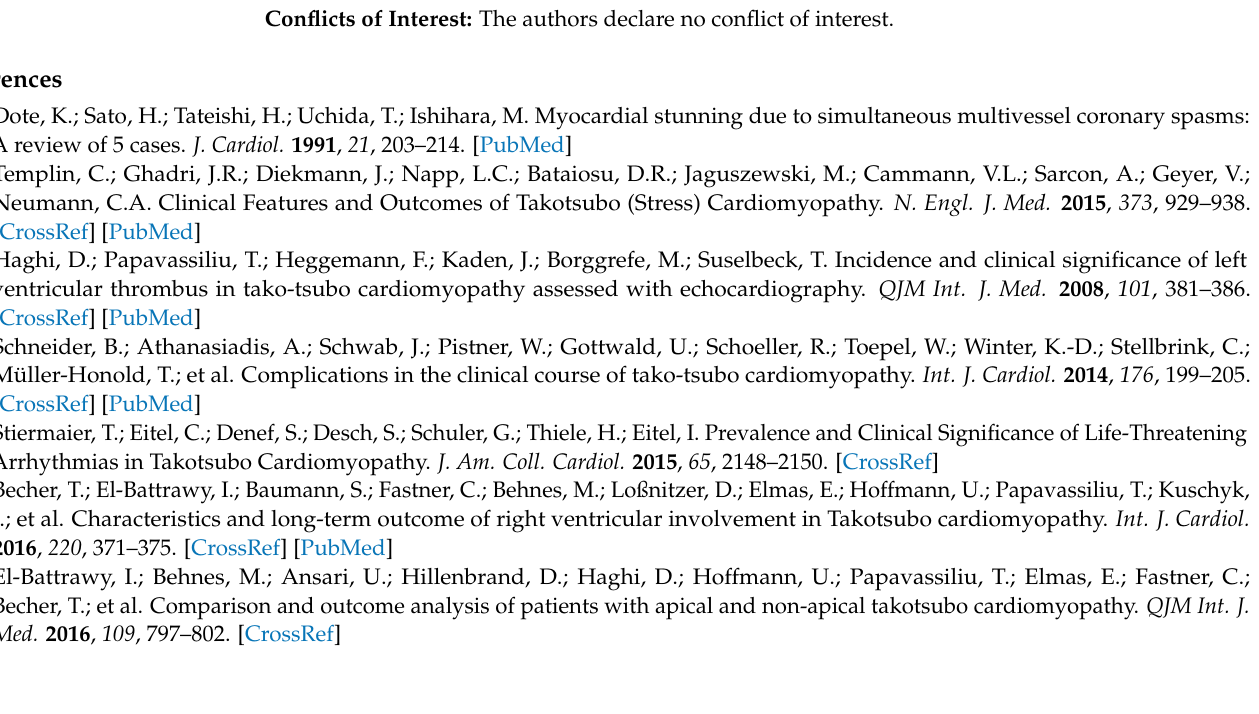
Figure S5. Immunofluorescence analysis of KCND3 protein in hiPSC-CMs; Figure S6. Effects of high concentration isoprenaline and high level of glucose on APs in hiPSC-CMs from donor 2; Figure S7. Effects of high concentration isoprenaline and high level of glucose on APs in hiPSC-CMs from donor